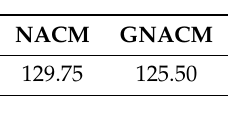
Table 1. Average response time (ms) of the proposed